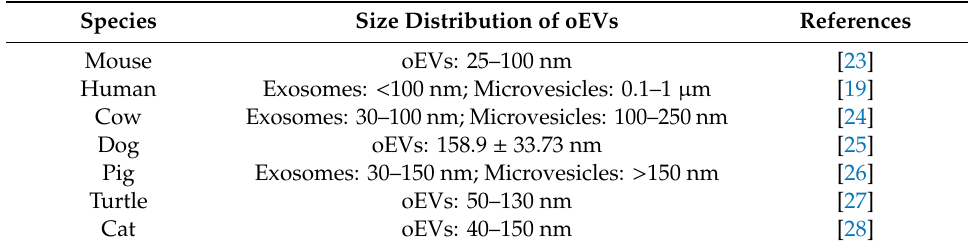
Table 1. Sizes of extracellular vesicles in the oviduct in di ff erent